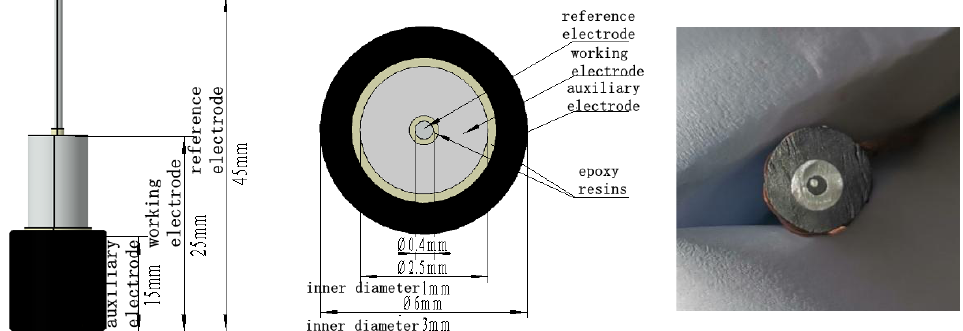
Figure 3. Miniature triple electrode.